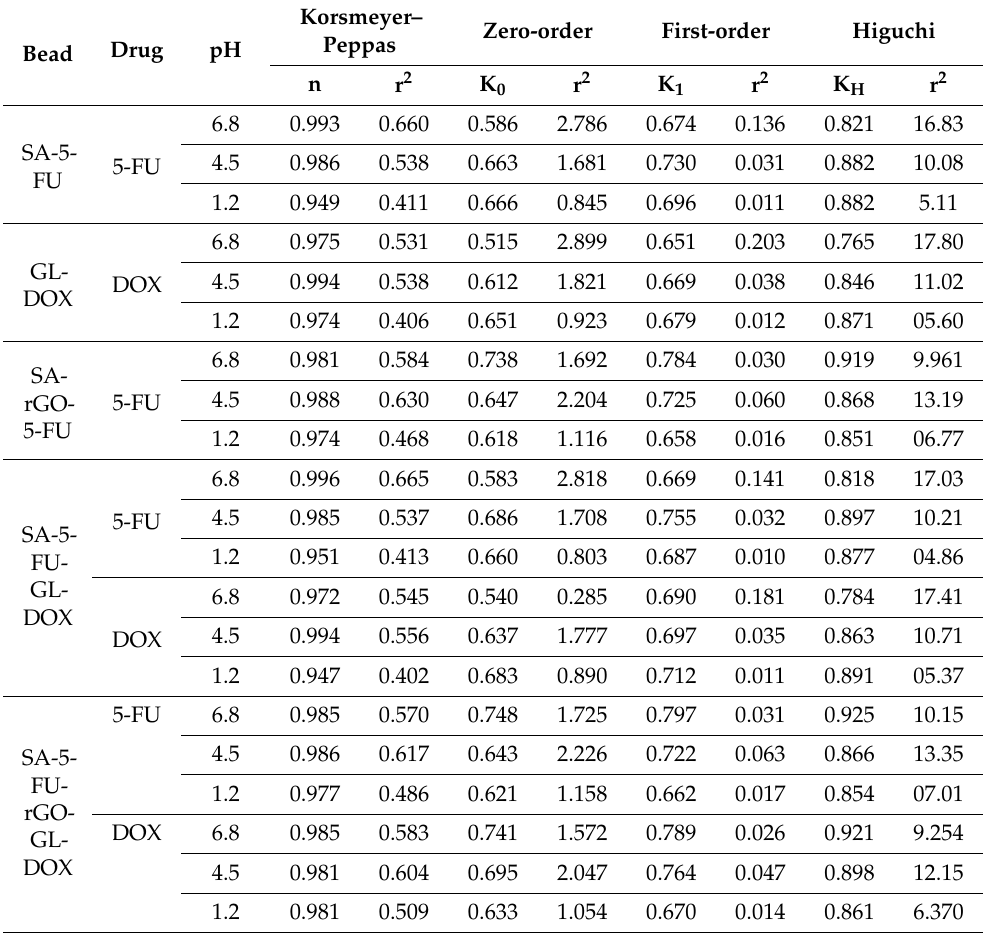
Table 2. Release kinetic parameters of different drug-loaded beads at pH 6.8, 4.5 and